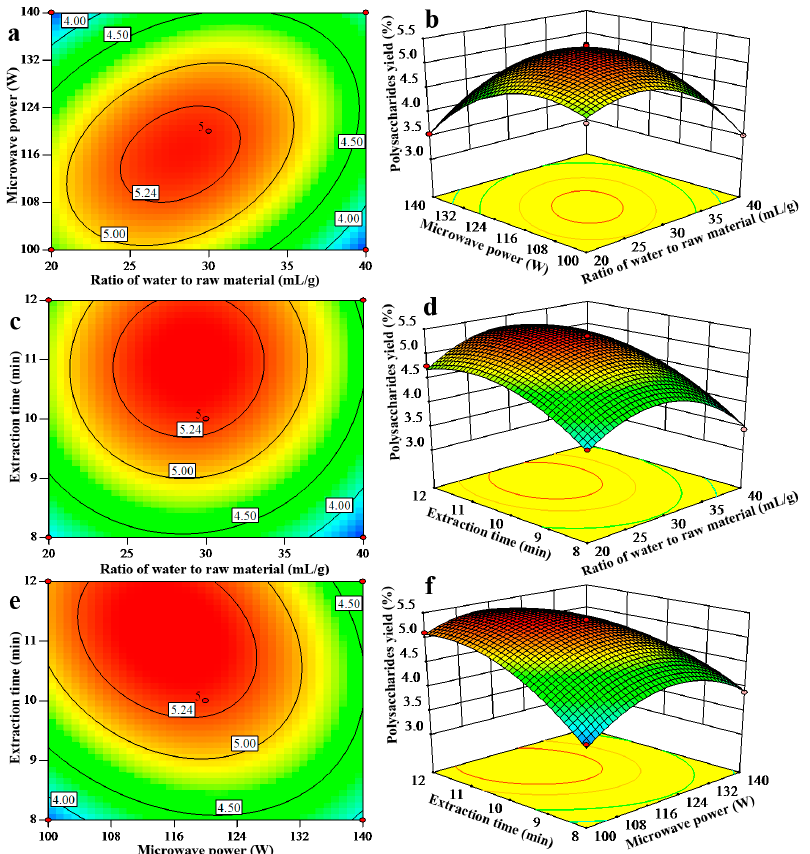
Figure 2. Contour plots and 3D-response surface plots showing the interactive effects of ratio of water to raw material and microwave power ( a , b ), ratio of water to raw material and extraction time ( c , d ), microwave power and extraction time ( e , f ) on yield of polysaccharides.